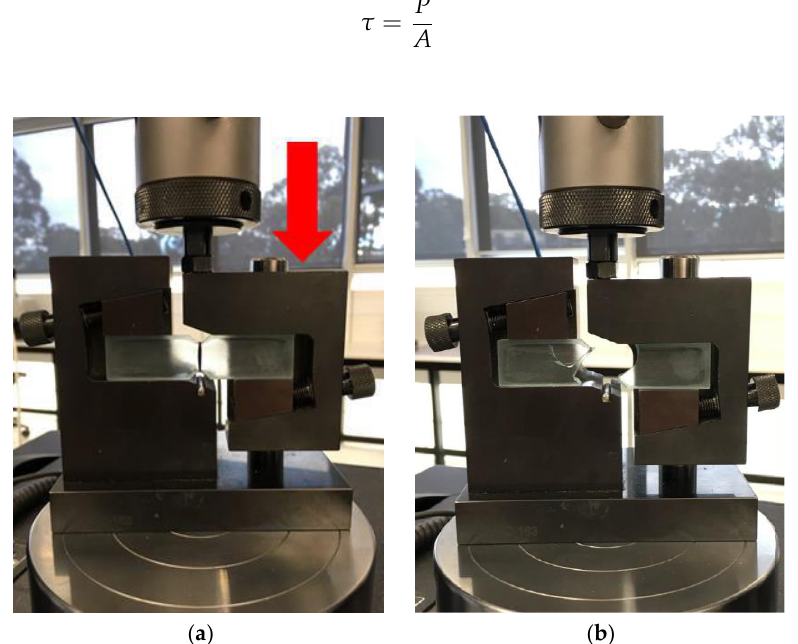
Figure 4. Specimen prepared for loading ( a ) Post fractured specimen ( b ).